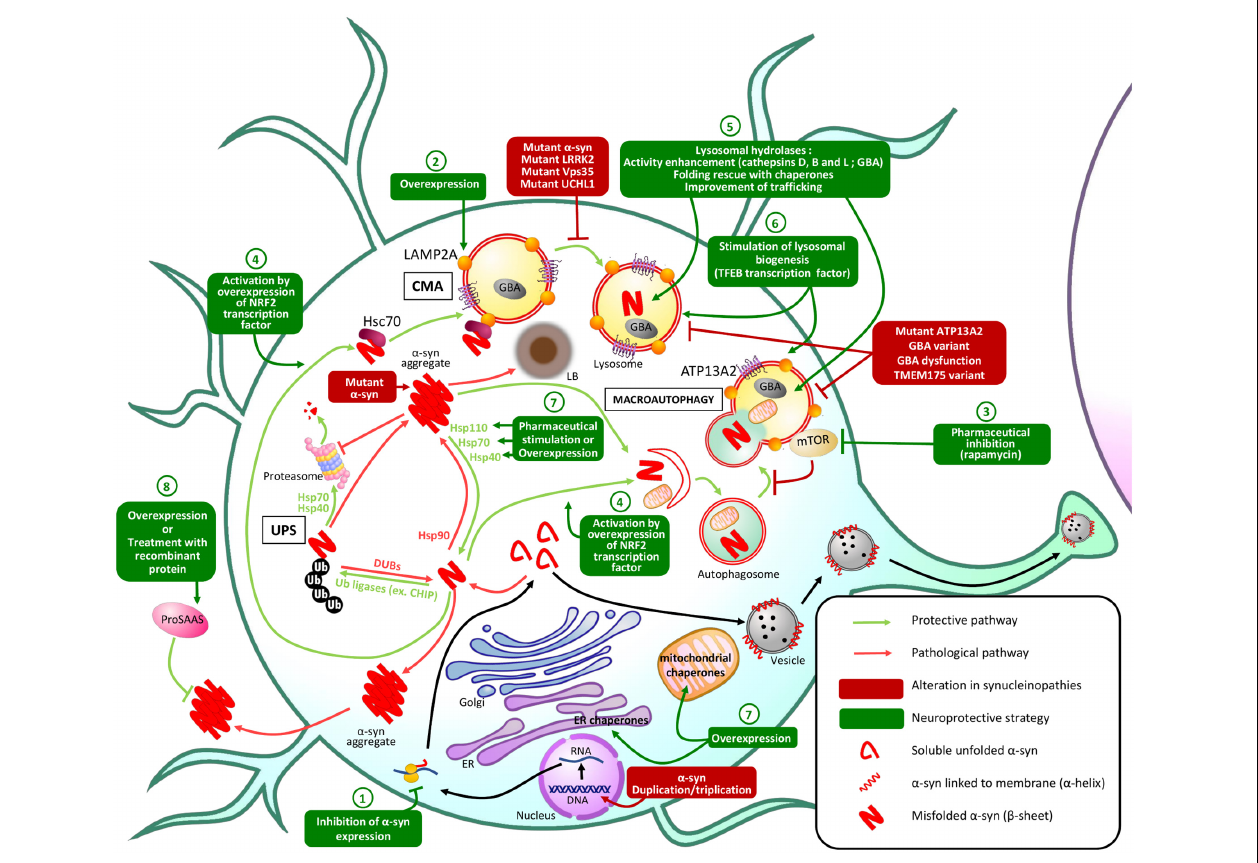
FIGURE 1 | Principal PQC mechanisms involved in α -syn homeostasis and potential therapeutic approaches. In physiologic conditions, misfolded α -syn protein is degraded by PQC machinery: the UPS is responsible for ubiquitination of α -syn leading to proteasomal degradation of α -syn, while macroautophagy and CMA both lead to lysosomal degradation of misfolded α -syn. In synucleinopathies, alterations in these protective mechanisms result in the accumulation of misfolded α -syn in aggregates and Lewy bodies (LB) that lead to neuronal dysfunction and death. Genetic or pharmaceutical approaches to restore altered PQC pathways or stimulate alternative PQC pathways: (1) Inhibition of α -syn expression could prevent its pathological accumulation. (2) Overexpression of Lamp2A lysosomal receptor could increase the CMA of misfolded α -syn. (3) Pharmaceutical inhibition of mTOR, an autophagy receptor, stimulates macroautophagy preventing α -syn accumulation and aggregation. (4) Overexpression of the transcription factor NRF2 activates both macroautophagy and CMA and stimulates the lysosomal degradation of misfolded α -syn. (5) Improving lysosomal hydrolases activity or (6) stimulating lysosomal biogenesis could also enhance α -syn lysosomal degradation. α -syn aggregation can also be prevented by stimulation or overexpression of (7) endogenous or (8) secretory